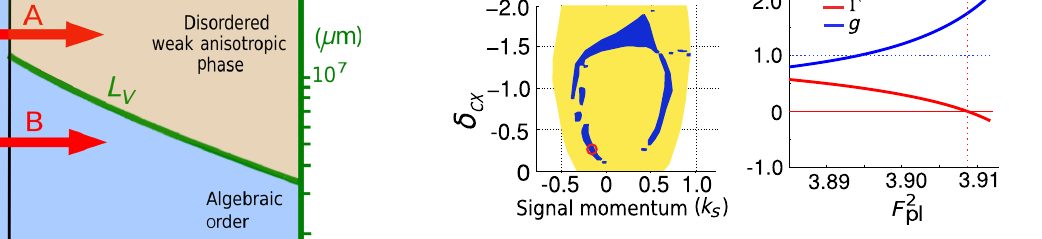
FIG. 8. Crossover between the KPZ scaling and the SA (negative Γ 0 ) regime with algebraic order. Left panel: Regions of detuning between the cavity photons and the excitons δ and CX signal momentum k (dark blue) for which the system can exhibit s a crossover between the KPZ phase and algebraically ordered FIG. 7. Crossover between SA (negative Γ 0 ) and WA (positive phase by tuning the pump strength F . The yellow region marks p Γ 0 ) regimes at finite length scales. Length scale for the vortex- stable KPZ solutions. Right panel: g and Γ as a function of the dominated phase in the WA regime L (green line) and the − 0 . 15 and δ − 0 . 25 v normalized pump strength F 2 for k s ¼ CX ¼ pl disordered phase in the SA L (blue line) as a function of the BKT (small red circle in the left panel). The crossover between the anisotropy parameter, tunable by the drive, for the polariton ≃ 3 . 909 : Γ changes sign KPZ and the SA regimes occurs at F 2 − 1 . 07 . The double red arrow A indicates a system with δ pl CX ¼ (vertical red dotted line) while g > 1 (dotted blue horizontal line). transition from the disordered WA to an algebraically ordered SA 1 . 4 , and we consider all values of k for which there is Here, k phase by increasing the external pump power in a system of size p ¼ s a nonzero mean-field solution and a stable aKPZ equation. Note L such that L < L < L . The double red arrow B indicates a v BKT that the stability analysis indicates that in the blue regions, the transition from the ordered WA regime to the ordered SA regime three-mode ansatz is unstable. This is confirmed by numerical by increasing the external pump power in a system of size L , studies [77], which show that the steady-state polariton field can < L where L < L . v BKT develop several secondary modes in addition to the three main ones. However, the secondary modes are typically orders of magnitude weaker, and we expect them to give only minor quantitative corrections to the values of g and Γ we find